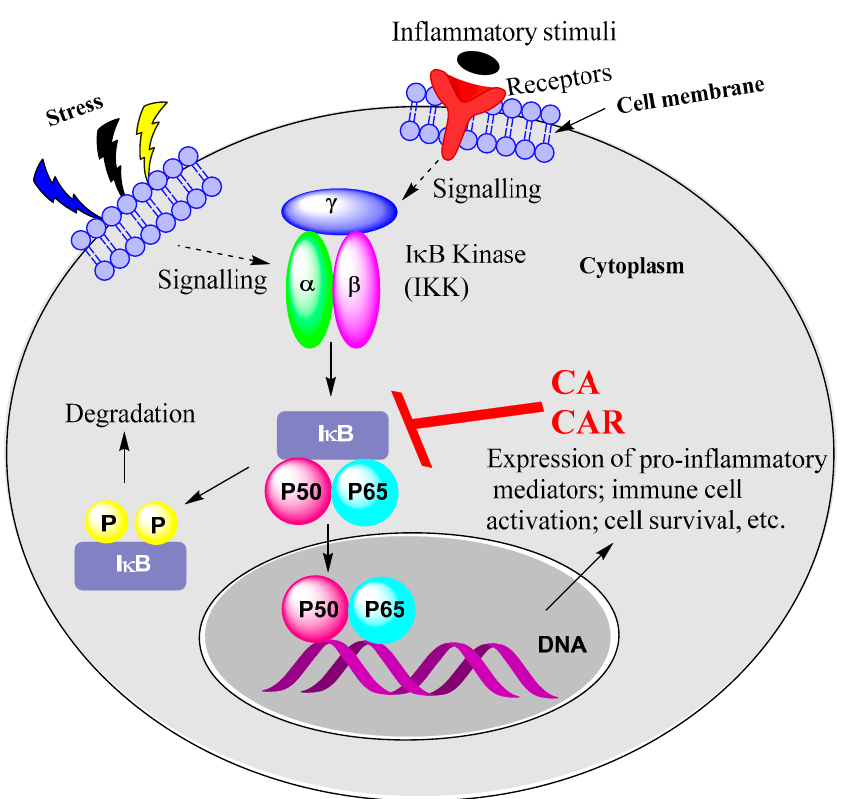
Figure 2. NF- κ B activation as a target for CA and CAR. Stress and inflammatory mediators and growth factors, PAMPs and cytokines such as TNF, IL-1 and IL-6 all activate NF- κ B. Their relevant receptors include growth factor receptors, TLRs and cytokine receptors such as TNF receptor. CA and CAR have been shown to suppress the activity of IKK, leading to inhibition of NF- κ B activation and/or mobilisation to the nucleus. Upstream signalling pathways could also be a target, as shown for CA, inhibiting the TLR-mediated activation of Syk/Src-PI3K and thereby abolishing the LPS-induced IKK